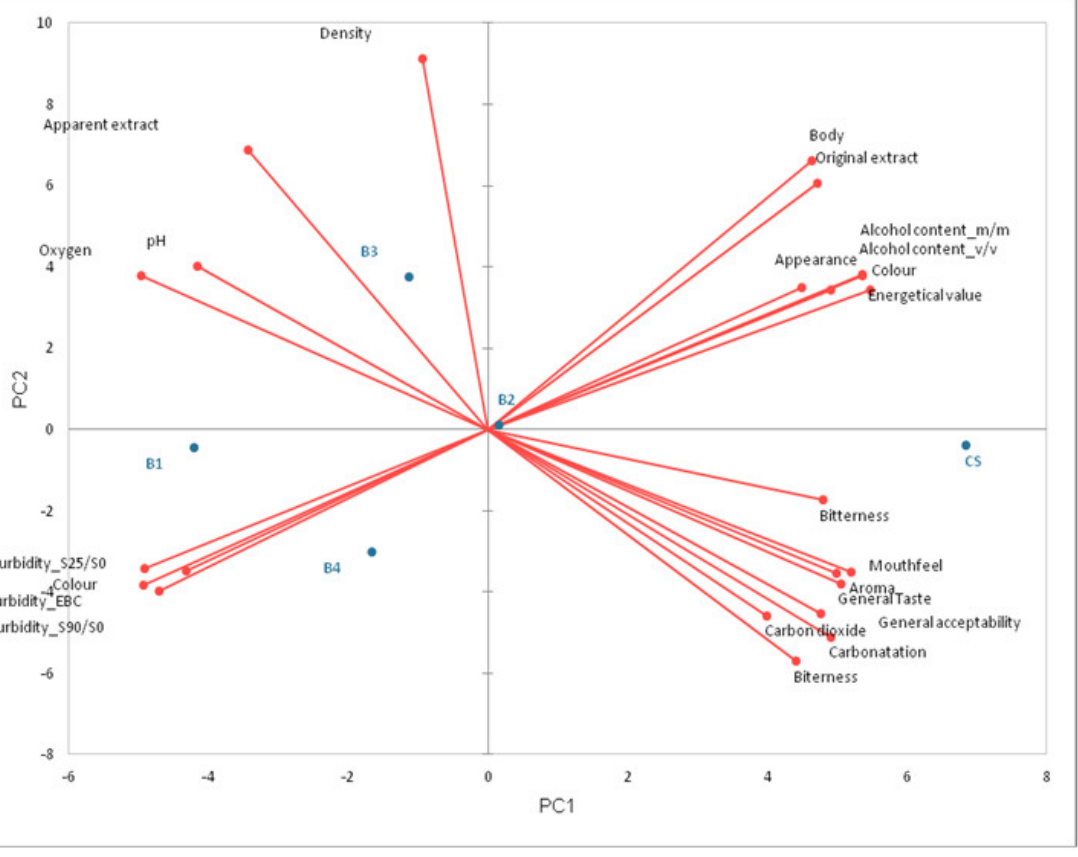
Figure 7. Principal component analysis of the physicochemical and sensory characteristics of the beer samples.